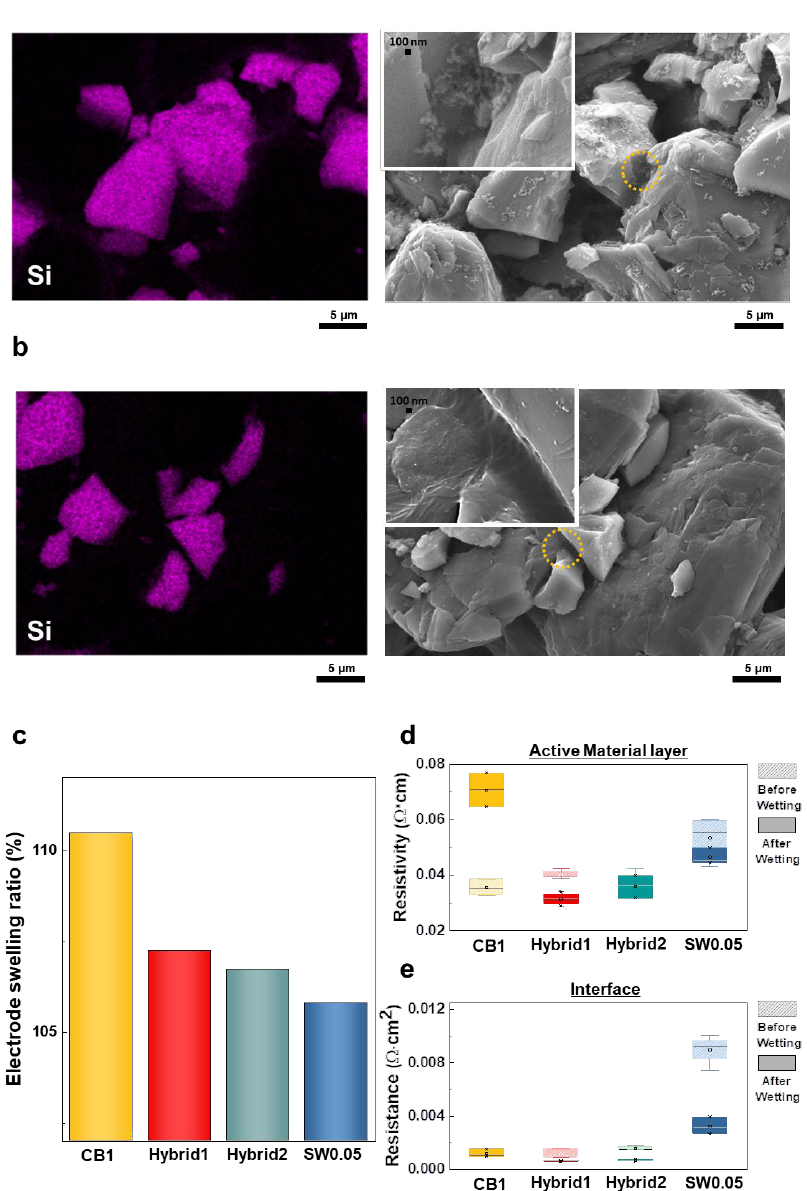
Figure 2. Characterization of electrodes: EDS and SEM images of electrode surfaces using ( a ) CB1 and ( b ) SW0.05. ( c ) Electrode swelling ratio after electrolyte wetting. ( d ) Change in active material resistivity after electrolyte wetting. ( e ) Change in interface resistance after electrolyte wetting.